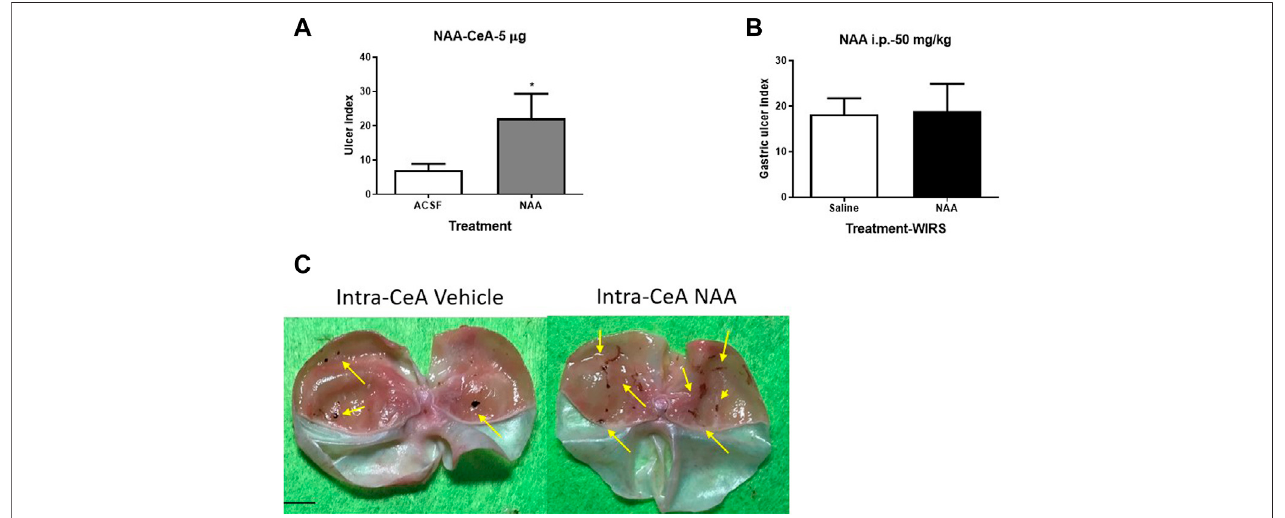
FIGURE 2 | Effect of pretreatment with NAA on the WIRS-induced gastric ulcer. (A) Intra-CeA administration of 5 μ g NAA aggravated WIRS-induced gastric mucosadamage.*p < 0.05,comparedwithACSFgroup.( n =5pergroup). (B) Intraperitonealadministrationof50 mg/kgdidnotaffectWIRS-inducedgastriculcer.( n =5 per group). (C) Representative camera images of gastric mucosa caused by water immersion with the treatment of intra-CeA of NAA or vehicle. The arrow indicates the ulcer position. Scar bar, 10 mm. All data are means ±